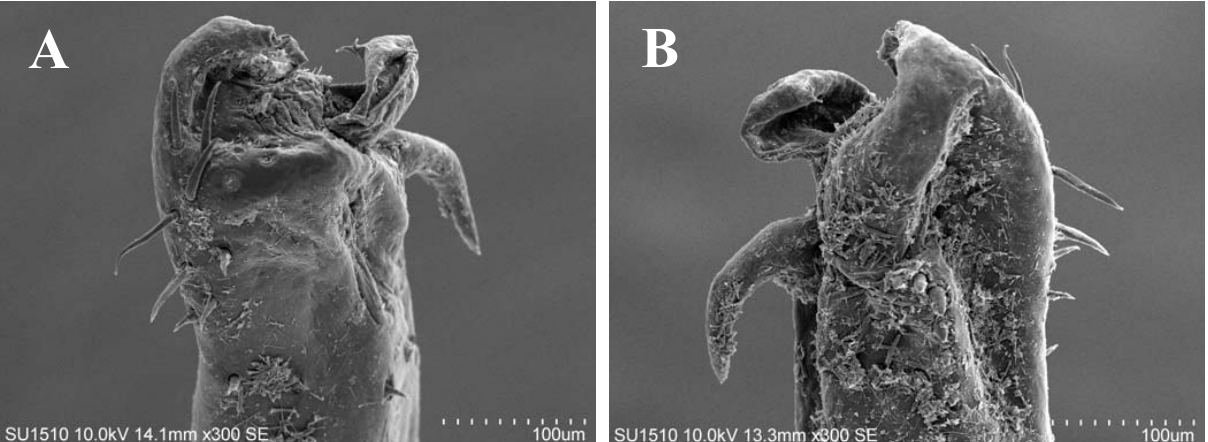
Figure 2. Malacoplax californiensis . A. Specimen (CW 6.3 mm) infested with parasitic Rhizocephala. B. Tip of first gonopod of male (CW 11.1 mm), frontal and caudal views. Scale bar, 0.1 mm.